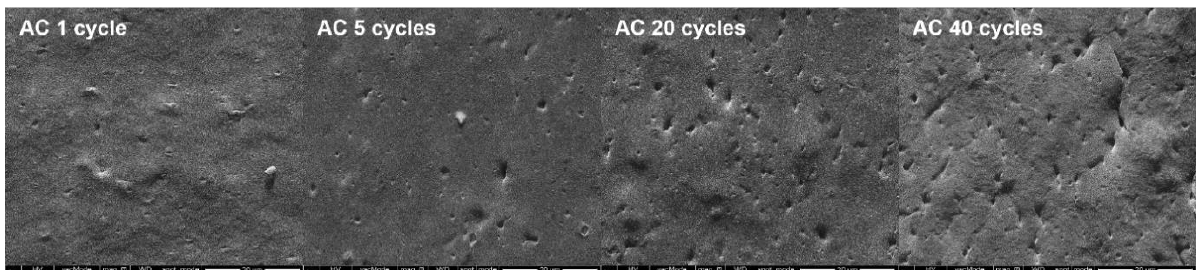
Figure 4. FE-SEM images of ( a ) fresh film and films treated with DI water, EtOH, and heptane. ( b ) Surface of films treated with AC after different number of test cycles.